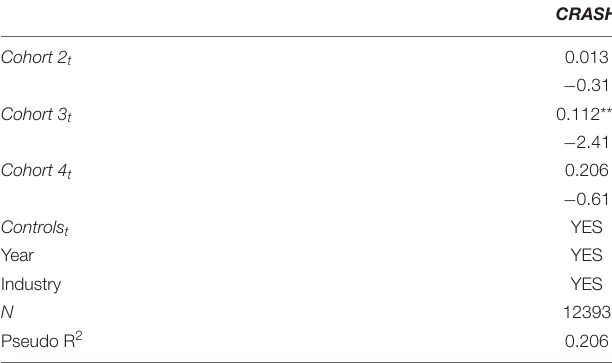
TABLE 13 | Robustness tests: Alternative proxy for stock price crash